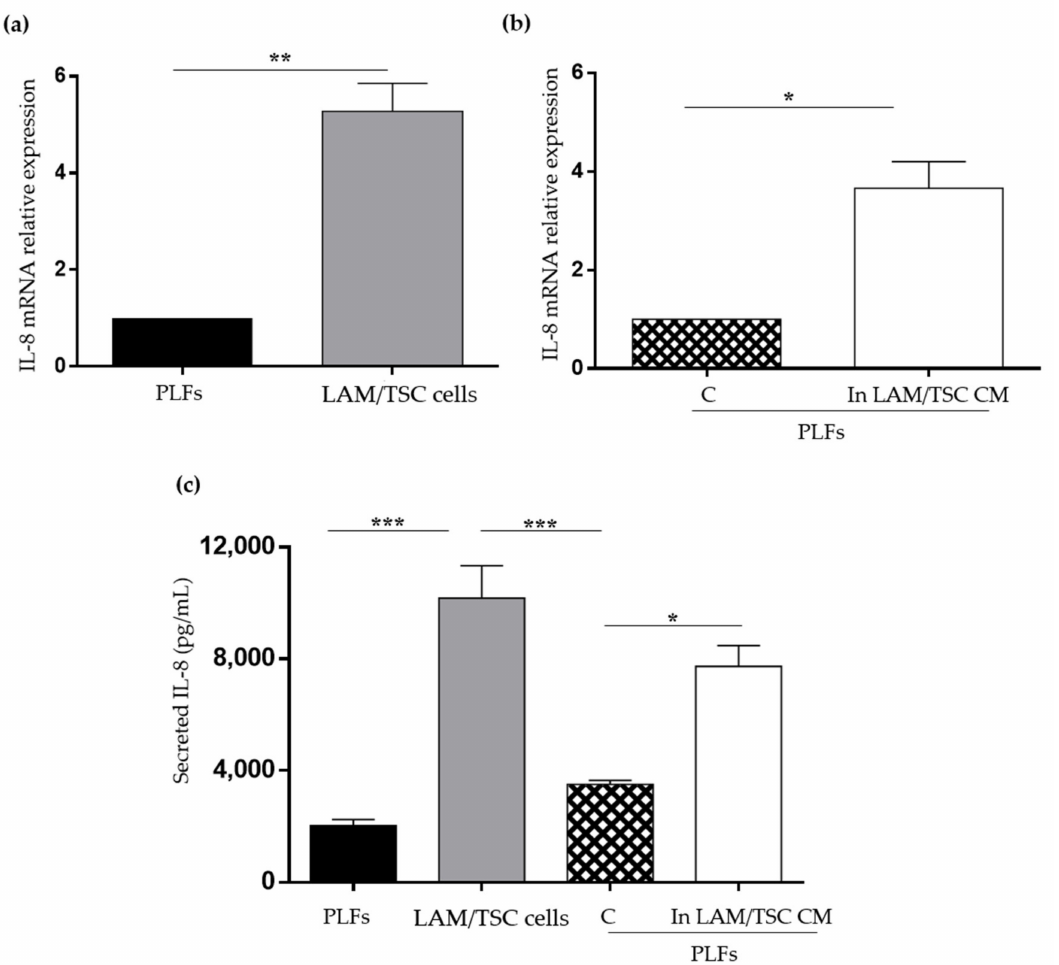
Figure 7. Analysis of IL-8 mRNA expression and secretion in PLFs and LAM/TSC cells, and in PLFs in CM. ( a ) mRNA relative expression of IL-8 was evaluated in PLFs and LAM/TSC cells. Results are shown as mean ± SEM ( n = 3). Student’s t -Test, ** p < 0.01. ( b ) mRNA relative expression of IL-8 was analysed in PLFs grown in their own CM (C) and in LAM/TSC cell CM. Results are shown as mean ± SEM ( n = 3), Student’s t -Test, * p < 0.05. ( c ) 48 h-IL-8 secretion was analysed by ELISA in PLF and LAM/TSC cell supernatants (columns 1 and 2), and in the supernatant of PLFs grown in their own CM (C) and in LAM/TSC cell CM (columns 3 and 4). The IL-8 levels in columns 3 and 4 are obtained by the subtraction of the IL-8 measured in the supernatant of PLFs (column 1) and in LAM/TSC cells (column 2) to the IL-8 measured in the PLFs grown in their own CM or in LAM/TSC cell CM, respectively. A total of 150,000 PLFs or LAM/TSC cells were plated for each sample. Results are shown as mean ± SEM, n = 3, ANOVA with Tuckey Test, * p < 0.05, *** p <